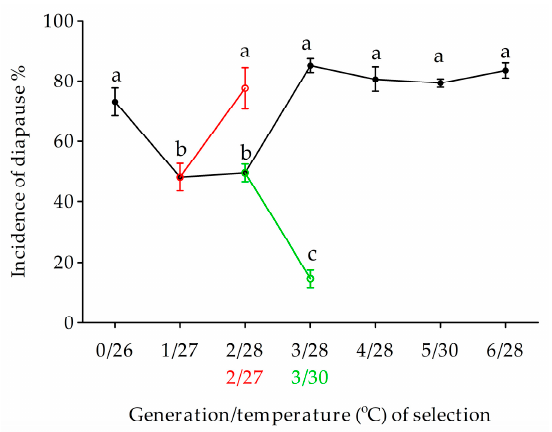
Figure 2. Changes in diapause incidences (%) in the process of establishing the univoltine strain (Lu) by recurrent selection under a 16 h daylength. Symbols and bars represent the mean ± SE values. Different lowercase letters indicate significant differences ( p < 0.05) among diapause incidence of different generation/temperature selections.